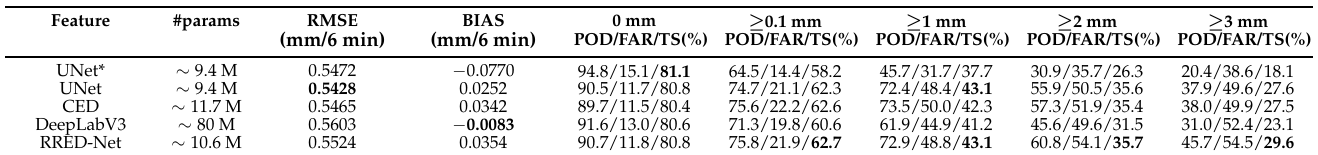
Table 7. Comparison of RRED-Net and other segmentation networks. Bold indicates that the best indicator in the current